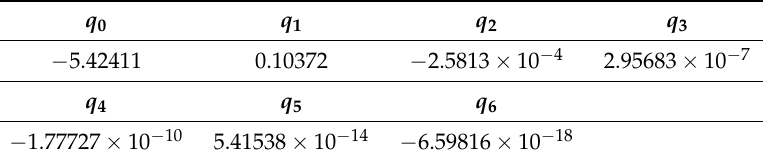
Table 6. The coefficient values for polynomial fitting of T h _ cw